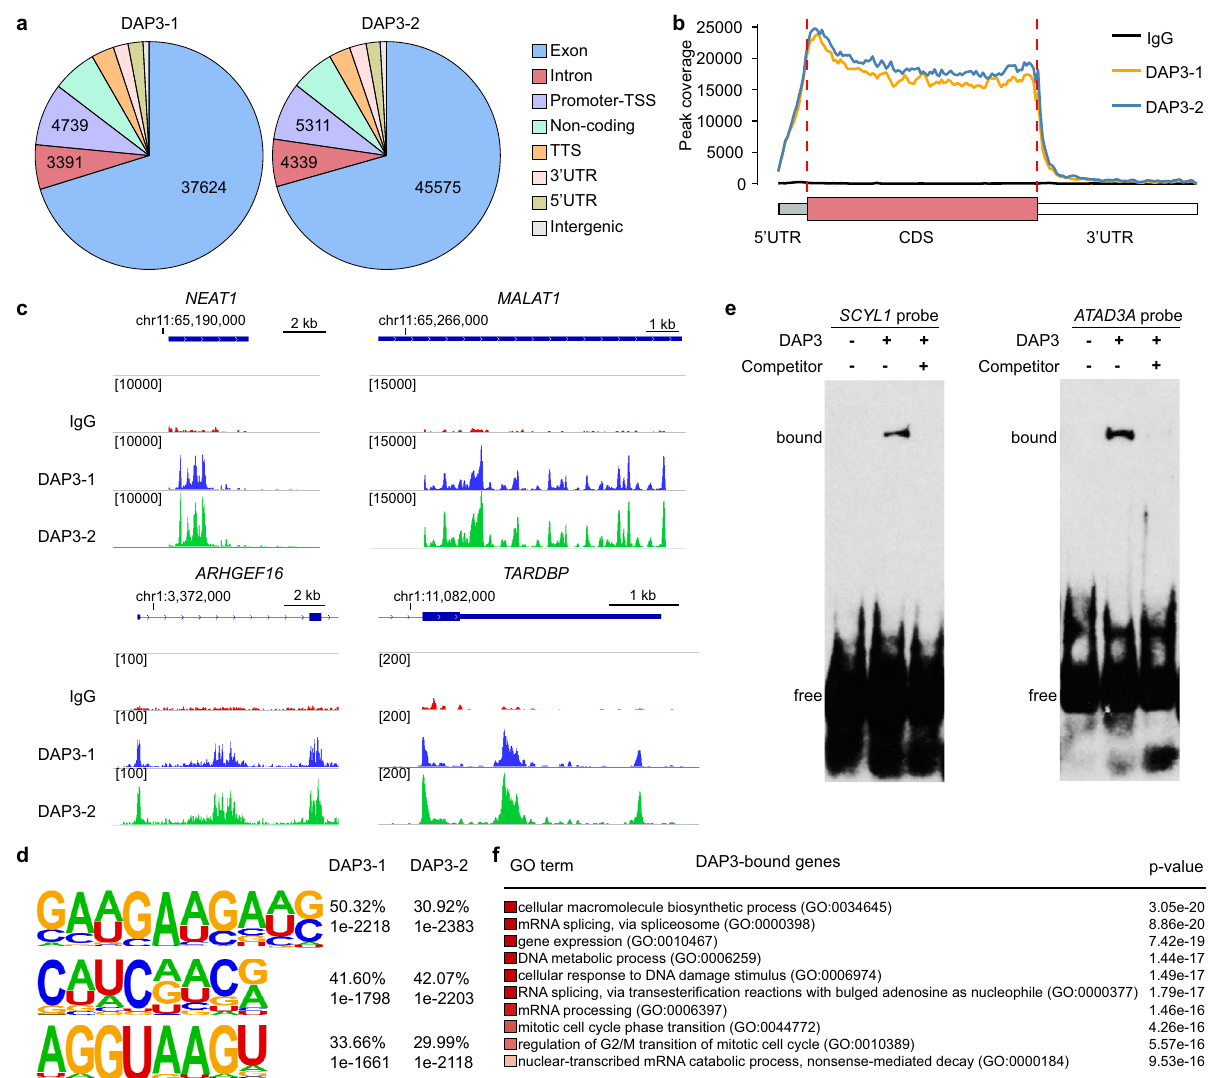
Fig. 1 RNA-binding landscape of DAP3 by eCLIP-Seq. a The distribution of the DAP3 eCLIP peaks in the human genome from biological duplicates (DAP3- 1 and DAP3-2). TSS transcription start site, TTS transcription termination site, UTR untranslated region. b The binned DAP3 eCLIP peak coverage across all expressed genes in EC109 cells. The 5 ’ UTR, CDS, and 3 ’ UTR of each gene are split into 13, 100, and 70 bins, respectively. CDS coding sequence. c Integrated genome viewer (IGV) browser tracks of the DAP3 eCLIP peaks spanning the genomic loci of NEAT1 and MALAT1 , 5 ’ region of ARHGEF16 , and 3 ’ region of TARDBP gene. Detailed information about all signi fi cantly enriched eCLIP peaks can be found in Supplementary data 1. d Top three most signi fi cantly enriched de novo sequence motifs in the DAP3-binding peaks using HOMER 12 . The percentage of peaks containing the discovered motifs and the p -values of the motifs calculated by binomial test against the random genomic background were shown. e REMSA analysis of the binding of DAP3 to two RNA probes that were generated from DAP3-binding sequences within SCYL1 and ATAD3A transcripts. A 100-fold molar excess of nonbiotinylated RNA probes was used as competitor. f Gene ontology analysis of DAP3-bound genes. The top 10 most signi fi cantly enriched biological processes are shown. The signi fi cance of enrichment for GO sets were evaluated by the WebGestalt 39 portal default hypergeometric test. Source data are provided in Source Data fi pipeline 15 . Compared to the scramble controls, alternative spli- DAP3 was inclined to repress exon skipping (58% and 71% of cing events in DAP3 -depleted cells [| Δ percent spliced-in ( Δ PSI) | ≥ 10%, false discovery rate (FDR) < 0.05, and splice junction read coverage ≥ 20] were de fi ned as DAP3-modulated splicing events. Intriguingly, we identi fi ed 7400 and 11,820 DAP3-modulated splicing events in 3262 and 4582 genes in EC109 and KYSE180 cells, respectively (Fig. 2a; Supplementary data 2 and 3). Approximately half of the DAP3-modulated spli- cing events are skipped exon (SE), followed by mutually exclusive exon (MXE; ~20%), alternative 5 ’ splice site (A5SS; ~10%), alternative 3 ’ splice site (A3SS; ~10%), and intron retention (IR; (108,399 and 110,895 in EC109 and KYSE180, respectively) were ~10%) in both cell lines (Fig. 2a; Supplementary data 2 and 3). strati fi ed into groups based on their PSI values (Supplementary